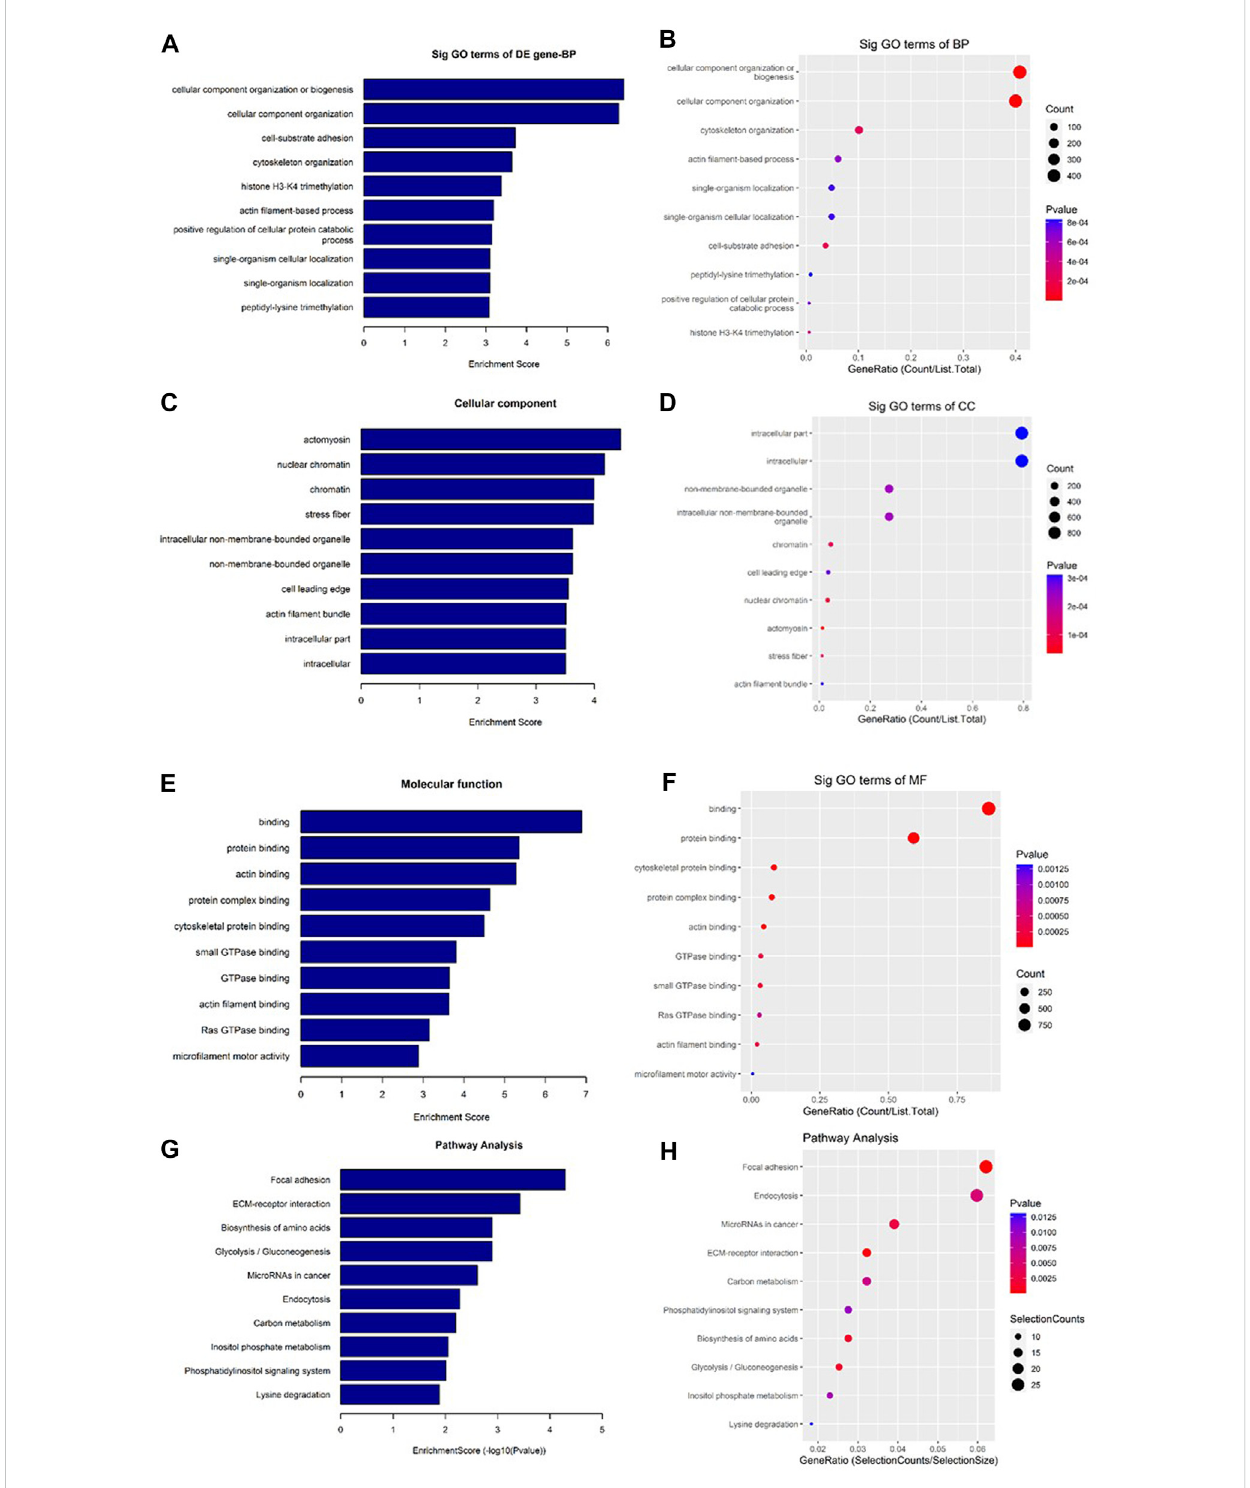
FIGURE 8 Gene Ontology (GO) and Kyoto Encyclopedia of Genes and Genomes (KEGG) pathway analyses of upregulated mRNAs in the GO-AgNPs treated caprine fetal fi broblast cells (CFFCs). GO analysis identi fi ed biological process (BP), cellular component (CC) and molecular function (MF) with the enrichmentscore[ (A,C,E) respectively]andgenecount (B,D,F) .ThetoptenenrichedKEGGpathwaysofsigni fi cantlyalteredmRNAgenes (G,H) .Thecolor intensity of the nodes shows the degree of enrichment of this analysis. The enrich-factor is de fi ned as the ratio of the differential genes in the entire genome. The dot size represents the count of genes in a